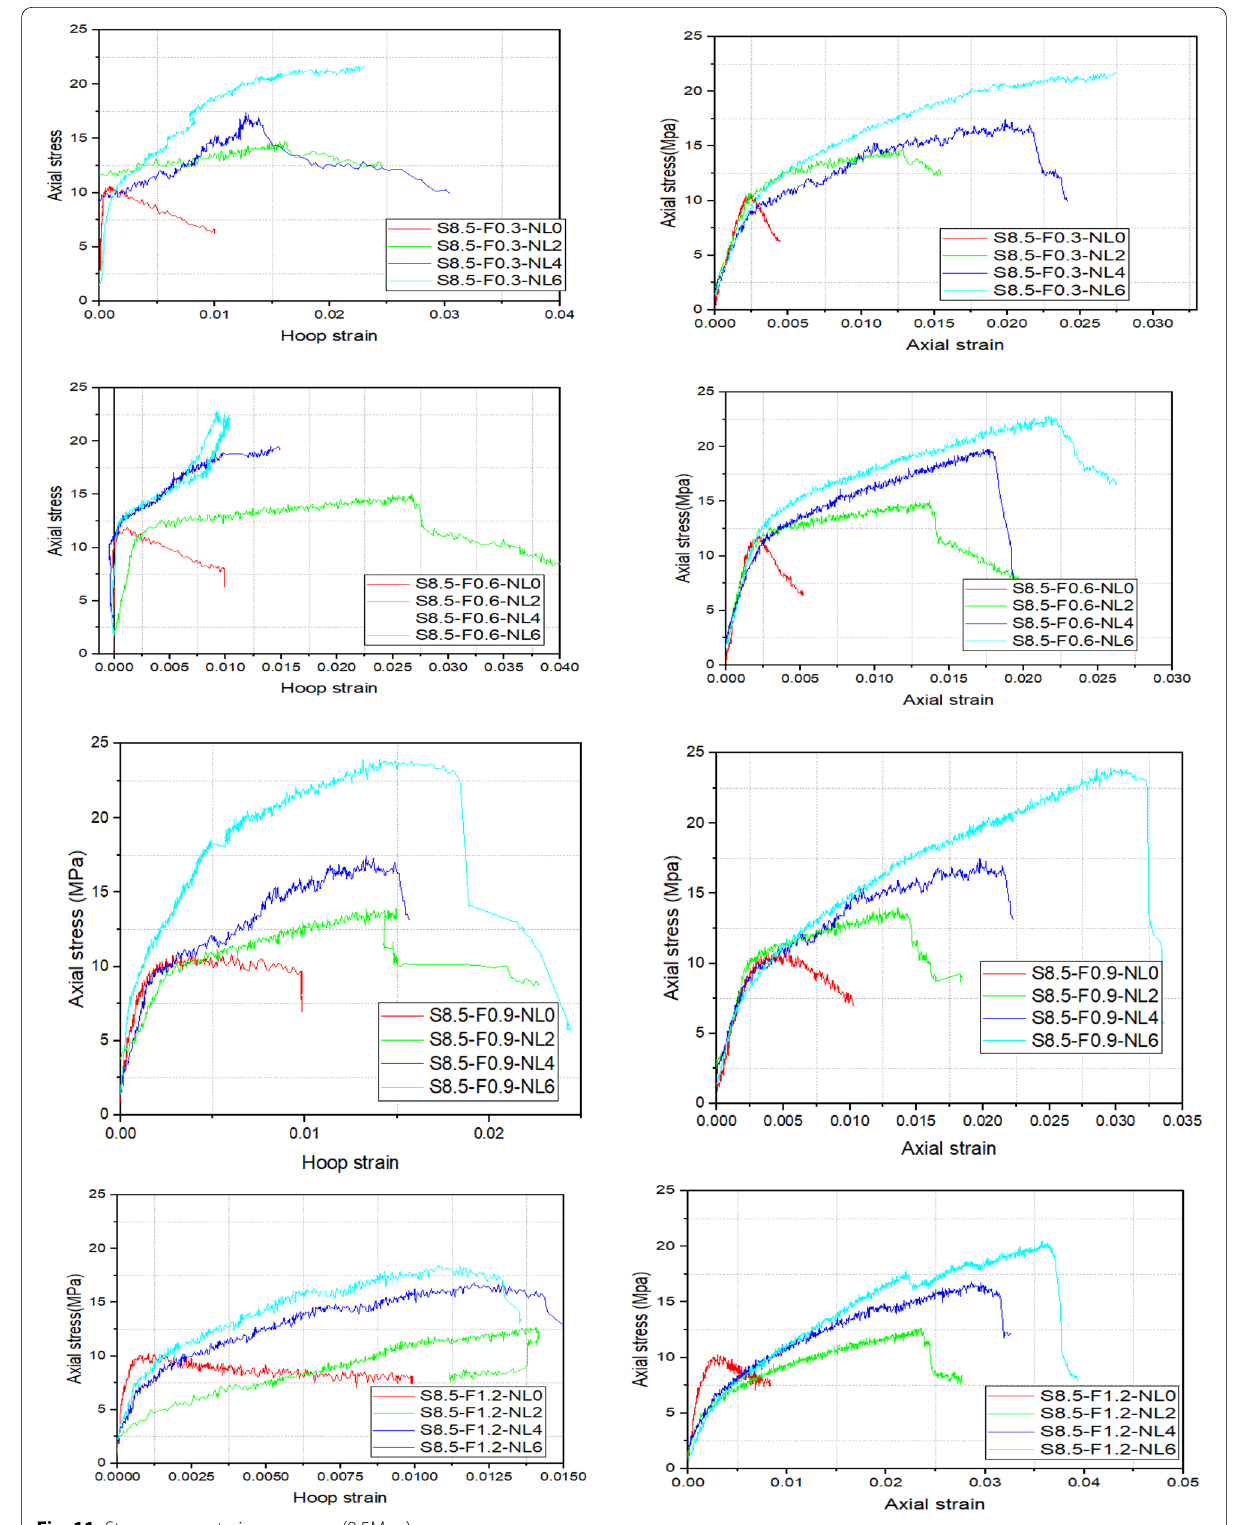
Fig. 11 Stress versus strain responses